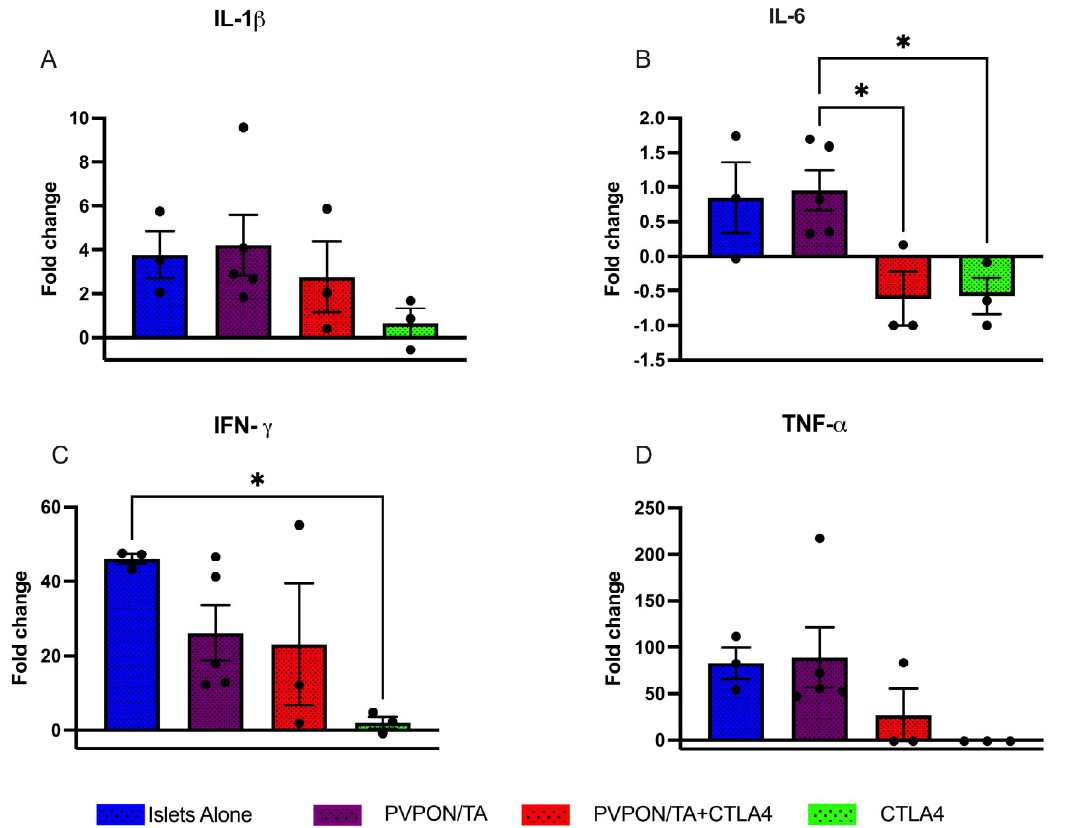
Figure 6. Intra-islet graft proinflammatory cytokines analysis of IL- β ( A ), IL-6 ( B ), IFN- γ ( C ), TNF- α ( D ) from murine allografts recipients procured 7 days post-transplant. C57BL/6 mice were transplanted with BALB/c islets (~500 islets) under the kidney capsule. Mouse recipient groups included islets alone ( n = 3, blue), PVPON/TA-coated islets ( n = 5, purple), PVPON/TA-coated islets+ CTLA-4-Ig ( n = 3, red), and Islets + CTLA4 Ig ( n = 3, green). Nondiabetic, non-transplanted C57BL/6 mice ( n = 4) served as control. Data expressed as a fold change from control grafts. Data points are represented as mean ± SEM. * p <